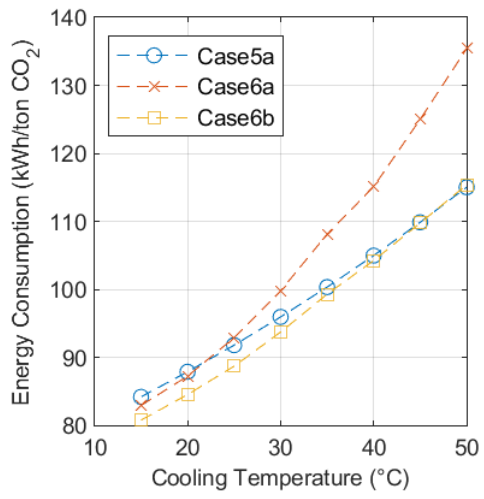
Figure 4. Variation in energy consumption for Cases 5a, 6a, and 6b with cooling temperature.